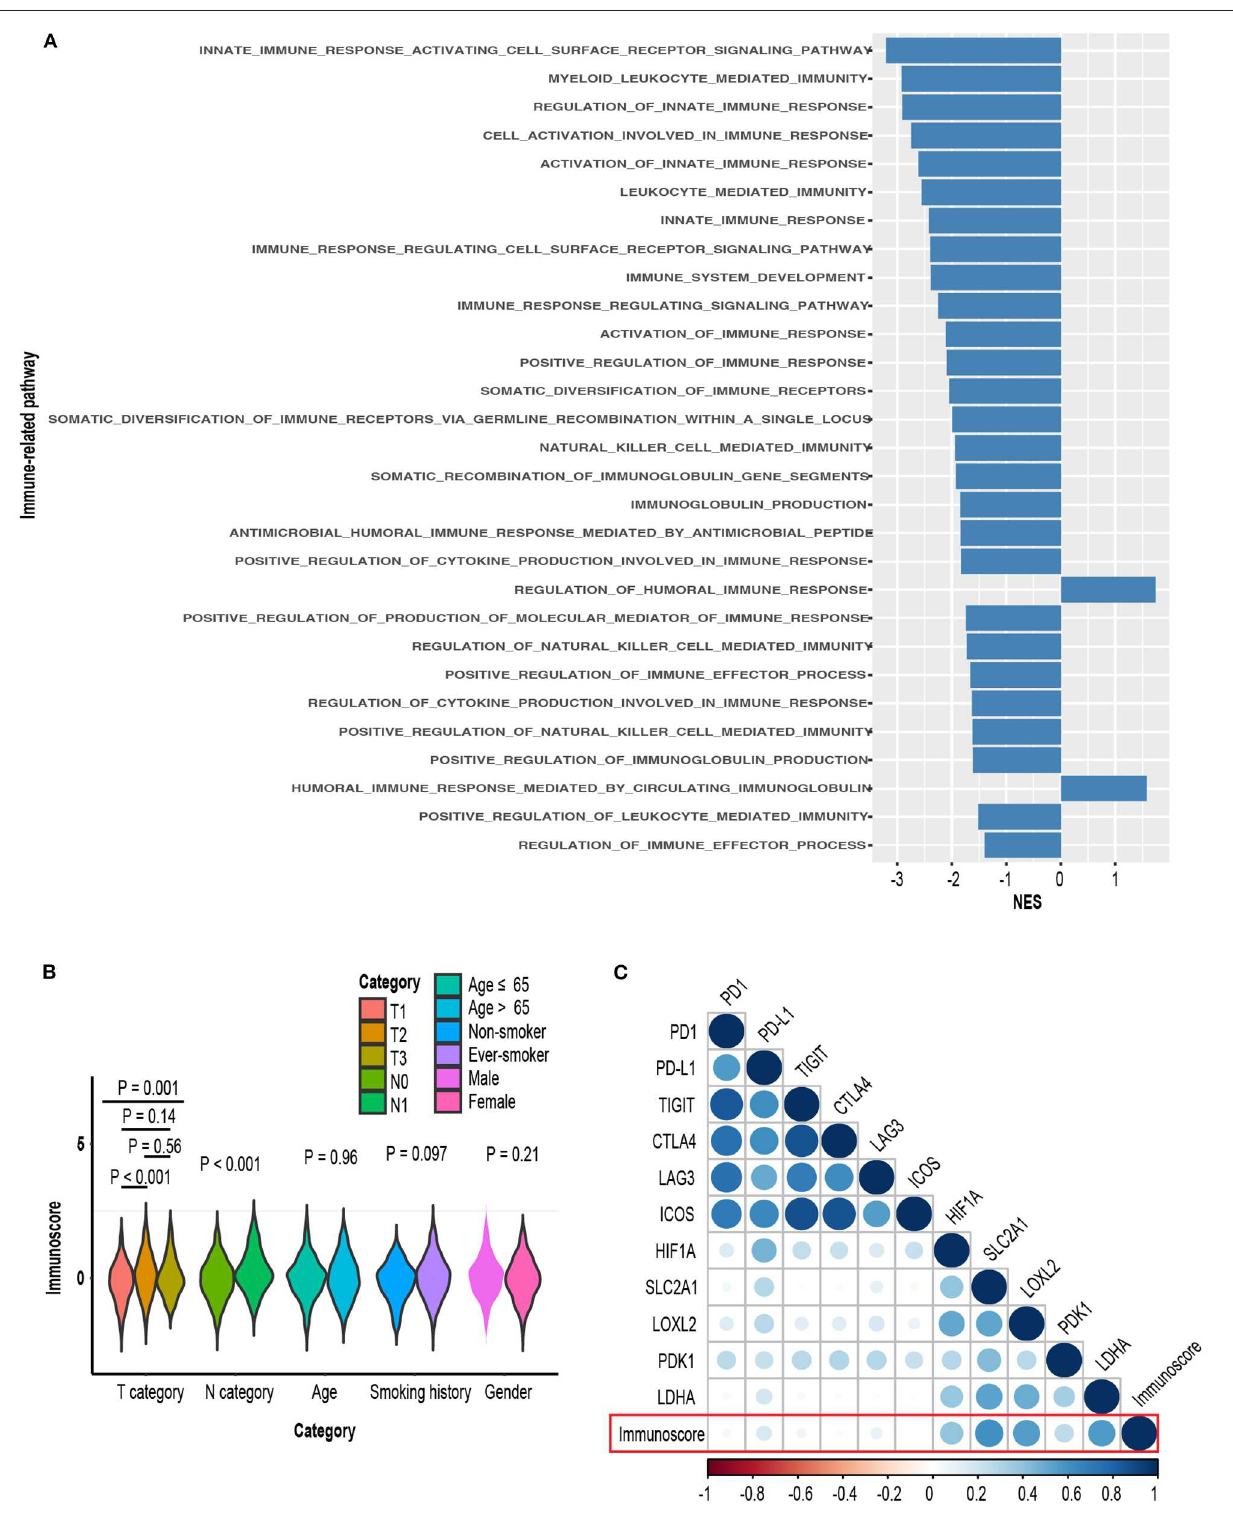
Frontiers in Oncology |